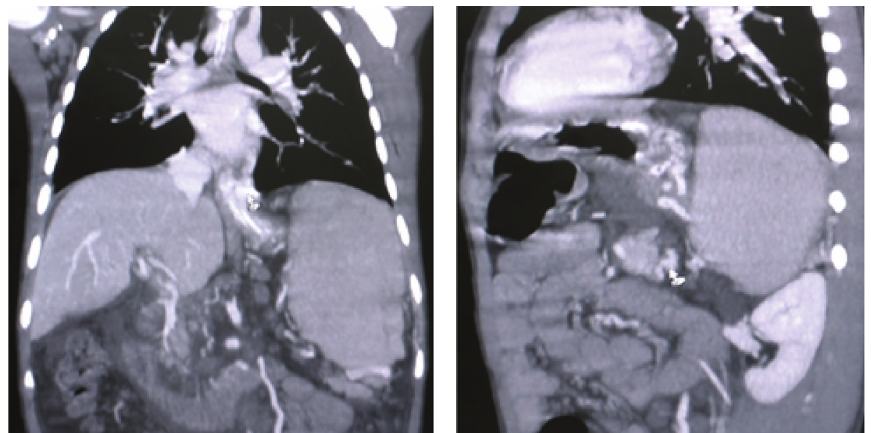
Figure 3: Dilation and tortuosity of spleen hilum veins and veins lining the esophagus and stomach.